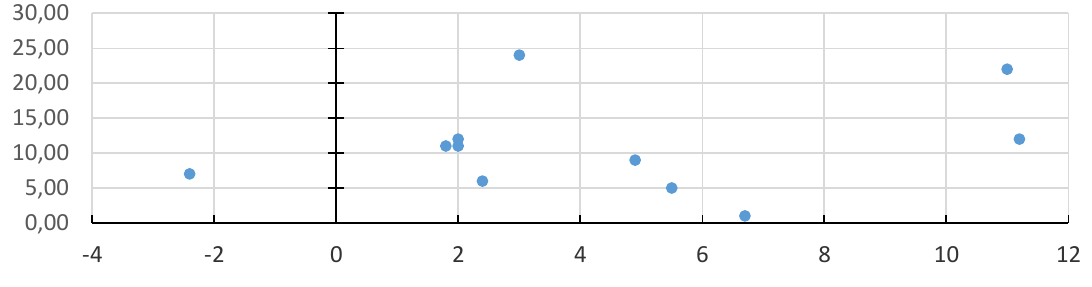
Figure 4. Y – Credit